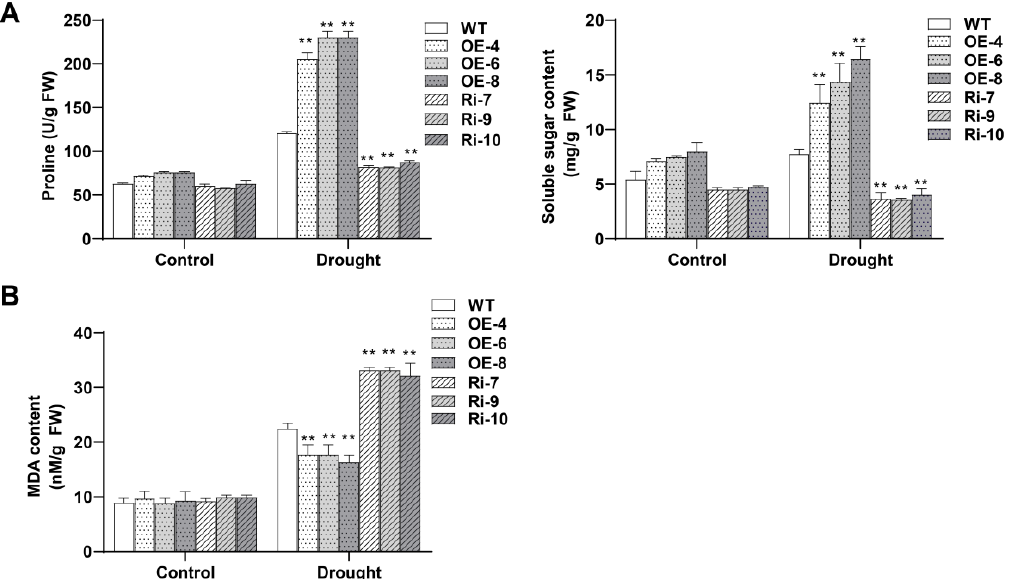
Figure 7. Evaluation of the osmotic regulators and malondialdehyde contents under drought stress. ( A ) Proline and soluble sugar contents in WT, OE- BrDHC1 , and RNAi- BrDHC1 plants (data represent the means ± SD of 3 replicates; Student’s t test was performed to compare differences between the wild-type and the transgenic plants under natural drought stress, along with one-way analysis of variance (ANOVA), ** p value < 0.01). ( B ) Malondialdehyde content analysis of WT, OE- BrDHC1 , and RNAi- BrDHC1 plants (data represent the means ± SD of 3 replicates; Student’s t test was performed to compare differences between the wild-type and the transgenic plants under natural drought stress, along with one-way analysis of variance (ANOVA), ** p value < 0.01).